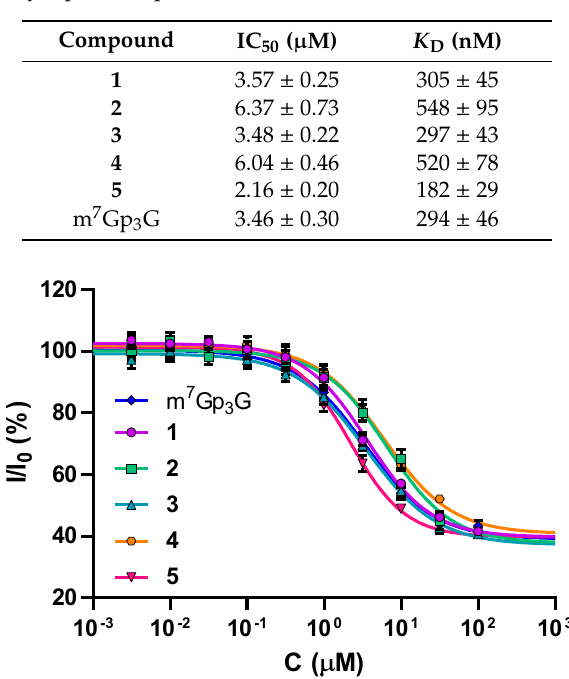
Figure 2. Dose–response curves for compounds 1 – 5 and m 7 Gp 3 G plotted from a competition binding assay for meIF4E [16]. eIF4E (75 nM) and a pyrene-labeled fluorescent probe (10 nM) were incubated